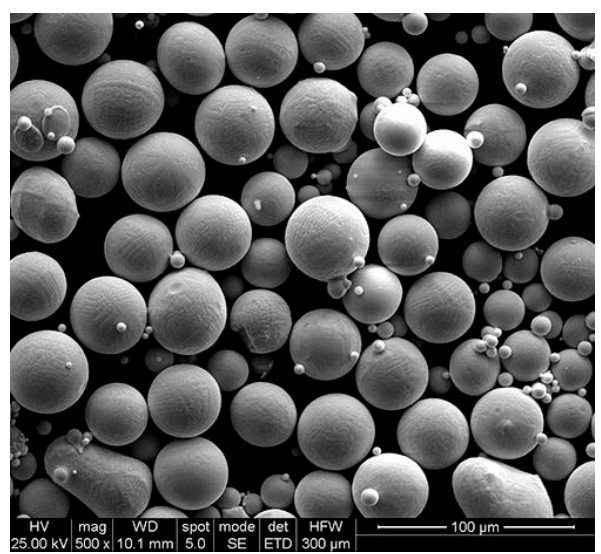
Figure 1. AZ61 magnesium alloy powders [24]. Table 1. Chemical composition of AZ61.